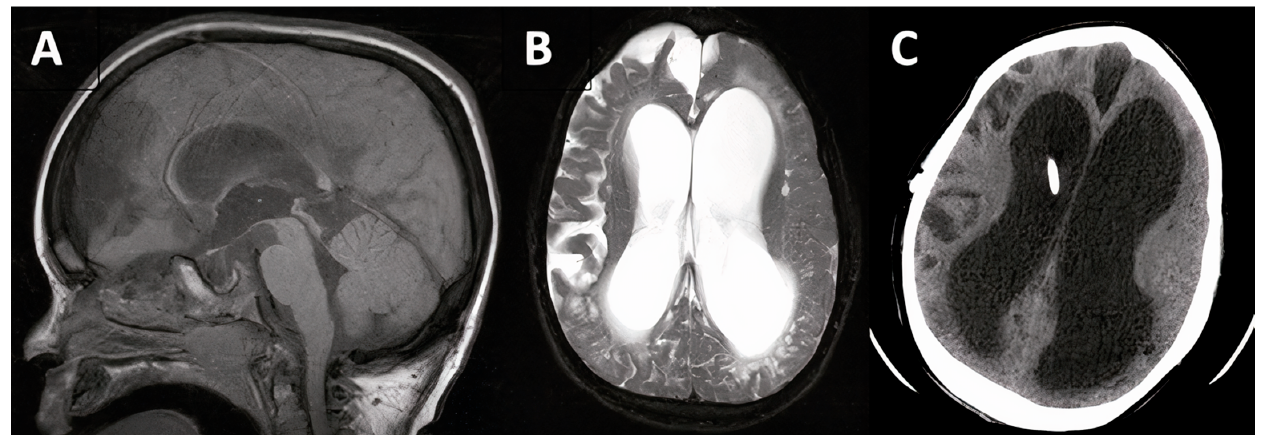
Figure 5. 10-year-old male patient with Hunter syndrome and hydrocephalus (case #8). Pre-operative T1-weighted mid- sagittal and T2-weighted axial magnetic resonance imaging (MRI, A , B ) and 1 year post-operative computed tomography scan with ventricular catheter visualized in the dilated right lateral ventricle ( C ).